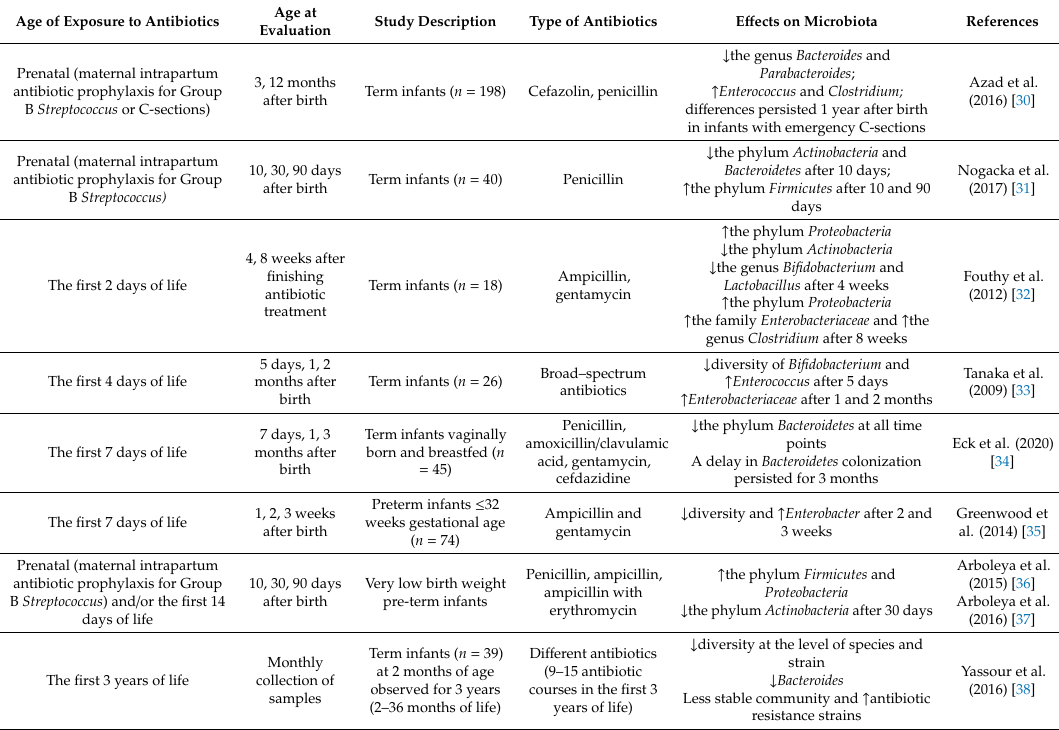
Table 1. Summary of studies demonstrating the e ff ects of antibiotic treatment in the pre-natal period and early post-natal life on the gut